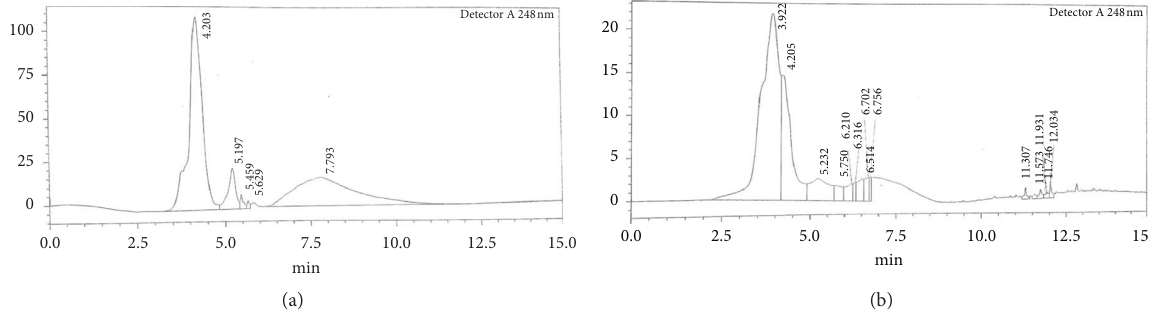
Figure 10: (a) Elution profile of the An-SBR-treated synthetic textile effluent with 100mg/L mixed azo dyes; (b) elution profile of the An- SBR- and MBBR-treated synthetic textile effluent with 100 mg/L mixed azo dyes.